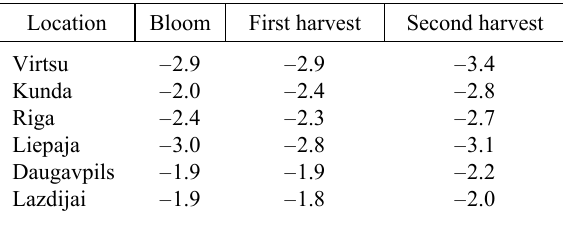
Table 4. Slopes of linear trends in phenological event